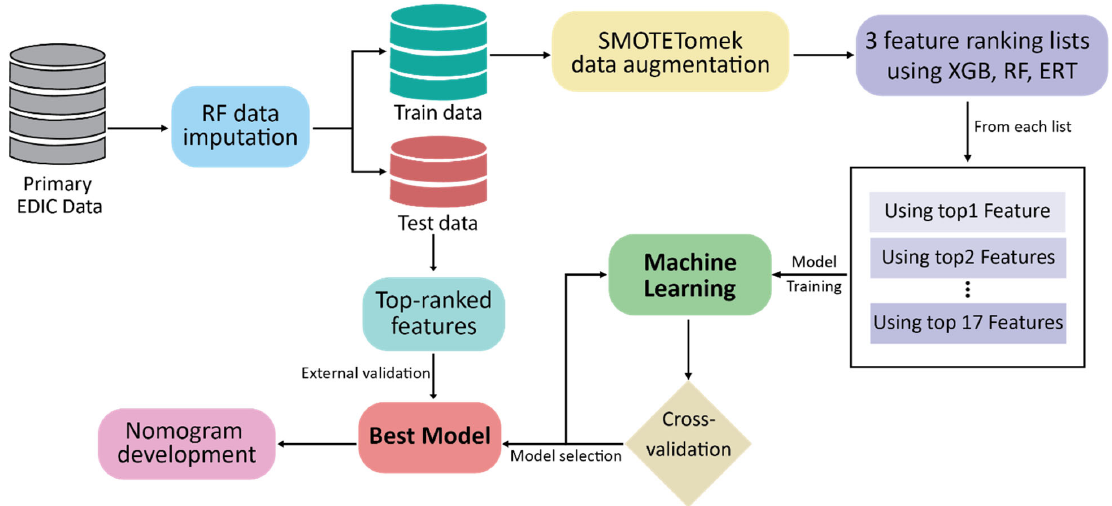
Figure 1. Overall working